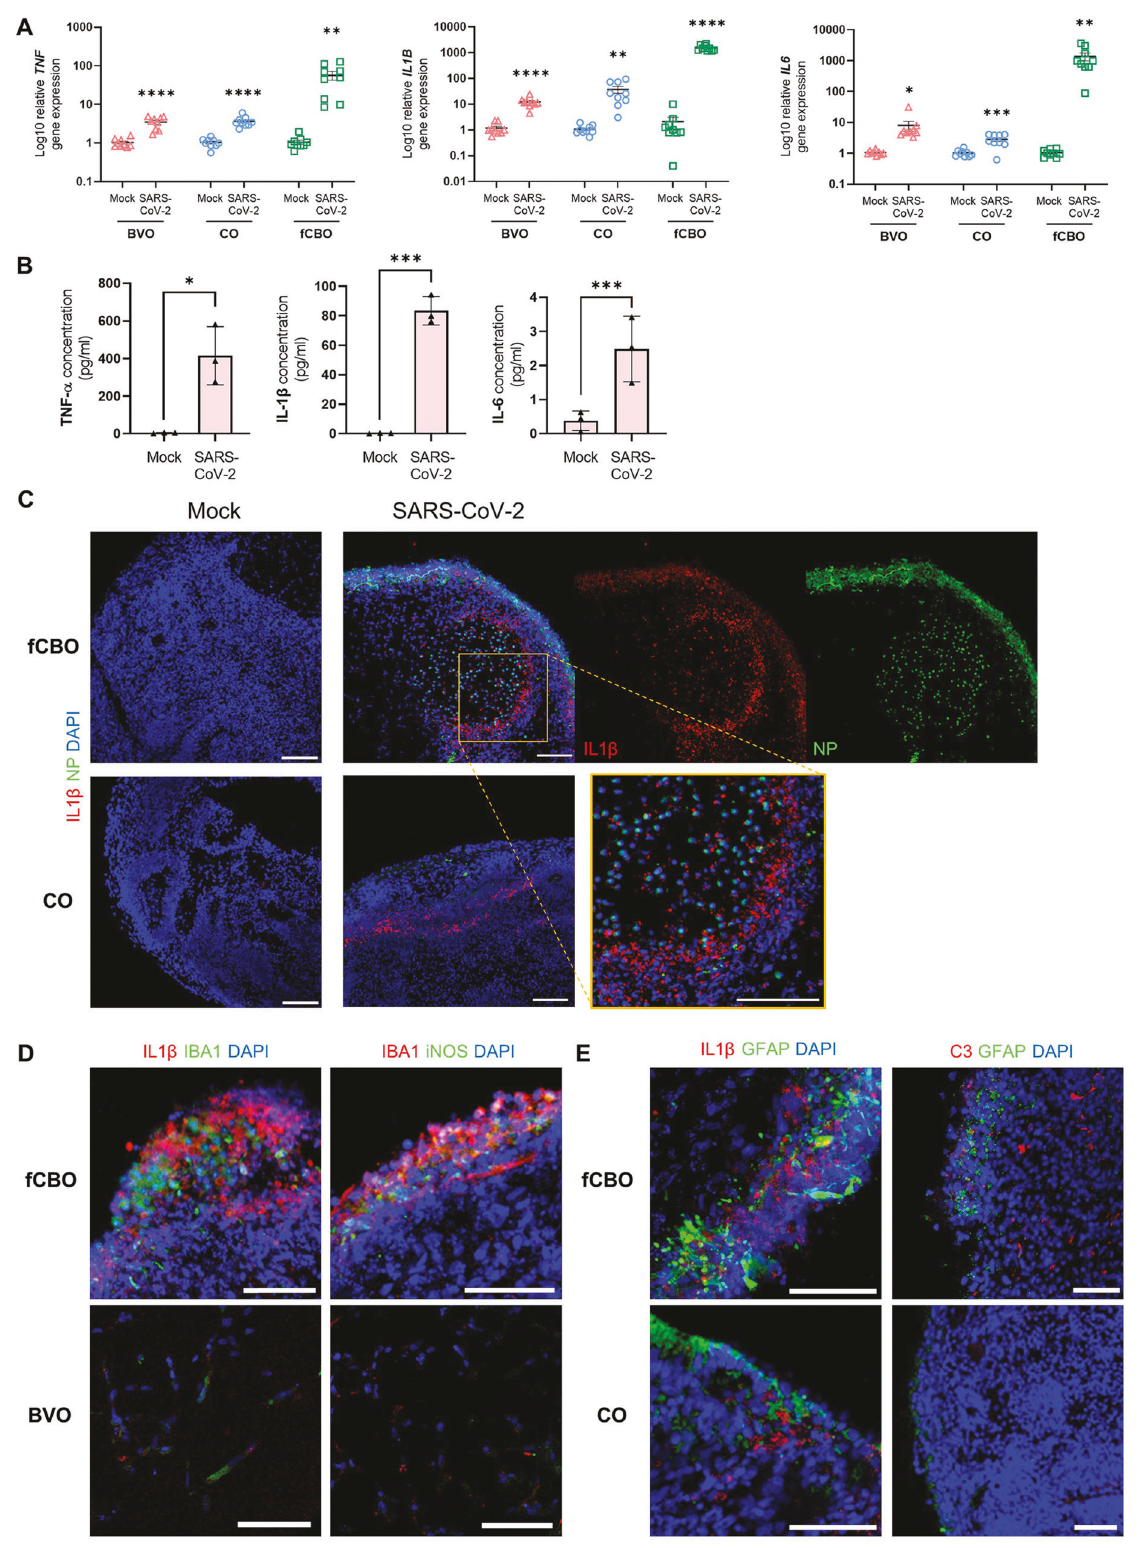
Fig. 7 Proin fl ammatory cytokines induce the activation of microglia and astrocytes in SARS-CoV-2 infected fused cortical-blood vessel organoids. A Relative gene expression of SARS-CoV-2 or mock infected BVOs, COs and fCBOs for TNF, IL1B and IL6 ( n = 9). B Quanti fi cation of released proin fl ammatory cytokines, TNF α , IL1 β and IL6, from SARS-CoV-2 or mock infected fCBOs by ELISA ( n = 3). C Immunostaining of SARS-CoV-2 or mock infected fCBOs and COs for IL1 β and NP. Scale bars = 100 μ m. D Immunostaining of SARS-CoV-2 infected fCBOs and BVOs for IL1 β and IBA1 (left) and activated glial marker iNOS and IBA1 (right). Scale bars = 100 μ m. E Immunostaining of SARS-CoV-2 infected fCBOs for IL1 β and GFAP (left) and activated astrocyte marker C3 and GFAP (right). Scale bars = 100 μ m. Values represent mean with individual data points plotted. Error bars are SEM of the mean. * p < 0.05, ** p < 0.01, *** p < 0.001 by unpaired two-sided t -test. Cell Death Discovery (2023)